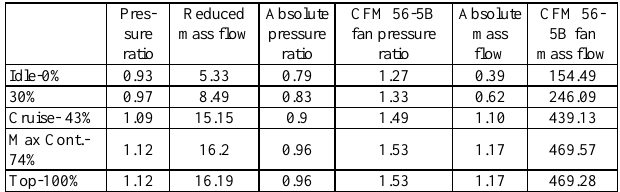
Table 6. Parameter of CFM 56-5B V = 0.44 Ma, H = 0 m